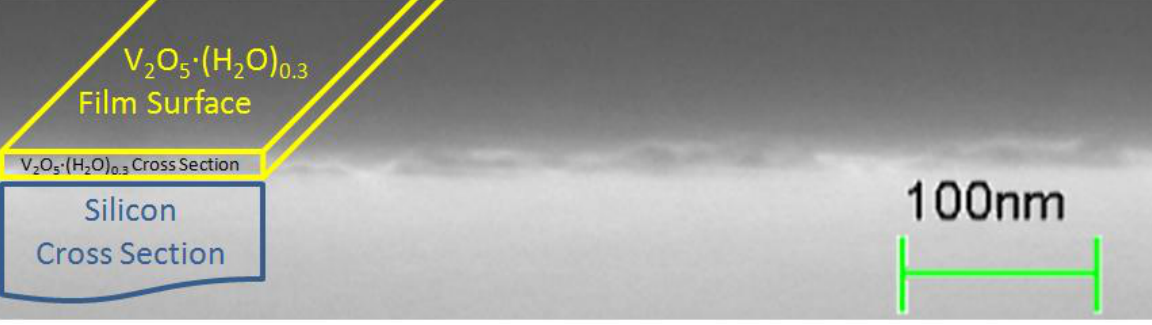
Figure 7. SEM cross section (tilted 17°) of 15 nm-thick cleaved V crystal silicon substrate showing film thickness and uniform morphology on the film